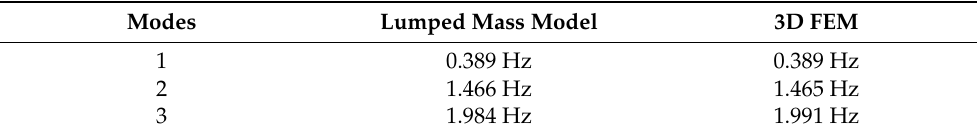
Figure 4. Mode shape comparison between FEM and lumped mass model in x-direction: ( a ) first mode, ( b ) second mode, and ( c ) third mode. Table 2. Comparison of natural frequencies of FEM and lumped mass model.